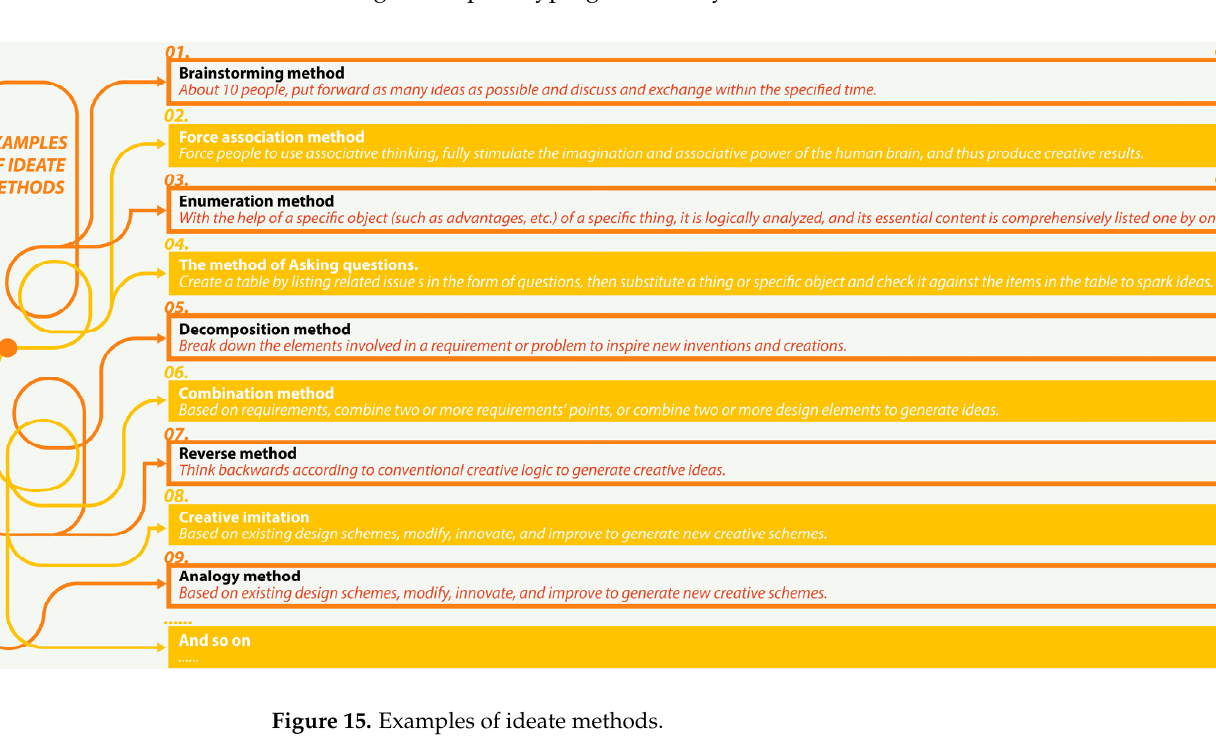
Figure 15. Examples of ideate methods.